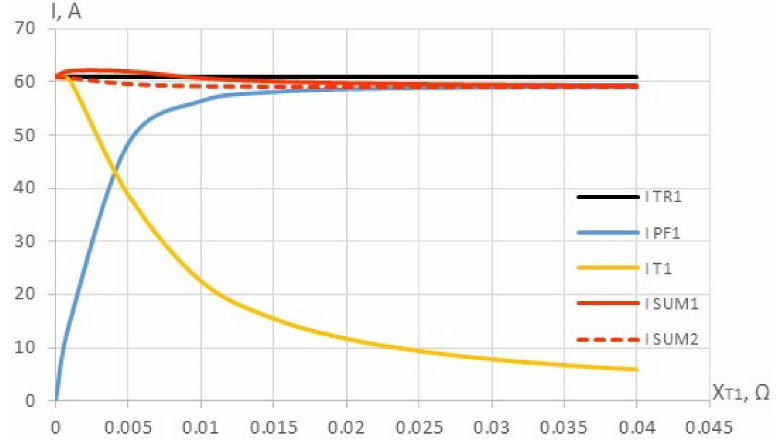
Figure 7. The dependences of the 5th harmonic currents I TR1 , I T1 , I PF1 , I SUM1 , I SUM2 on the energy system impedance X T1 .